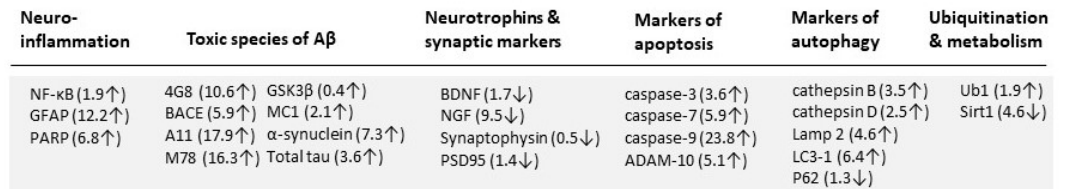
Figure 1. Relative changes in the expression of proteins of interest in brain tissue of 3xTg-AD mice. Changes shown as increased ( ↑ ) or decreased ( ↓ ) in protein expression in brain of 7-month-old 3xTg-AD mice compared to brain from age-matched WT mice. Numbers in parentheses represent the fold change compared to WT mice. Based on the Western blot data, proteins relating to neuroinflammation, toxic species of A β , apoptosis, autophagy and ubiquitination were increased whereas protein levels of neurotrophins, synaptic markers and SIRT1 were reduced in the 3xTg-AD mouse brain compared to age-matched WT mice.